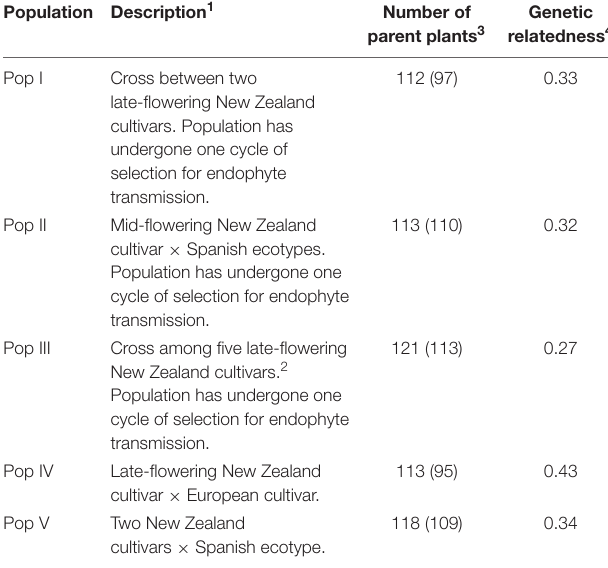
TABLE 1 | Description of L. perenne populations used in this